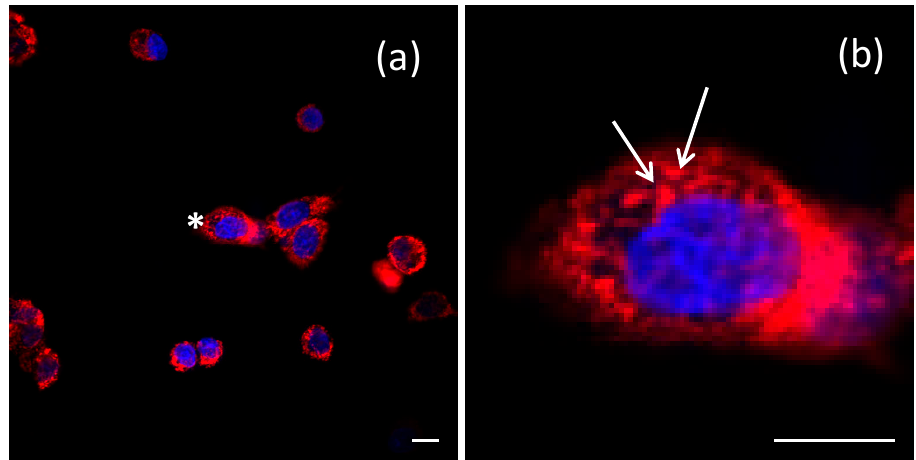
Figure 5. Intracellular localization of dextran 70,000-coated SPIO-NPs labelled with rhodamine 123, in C6 cells after 24 h of incubation, is shown by confocal microscopic images ( a ). The image on the right ( b ) zooms into the cell labeled with an asterisk in ( a ) to illustrate the dotted labelling (arrows), which presumably indicates endosomal–lysosomal uptake. Nuclei stained with Hoechst 33342 in blue. Scale bars 20 µm.